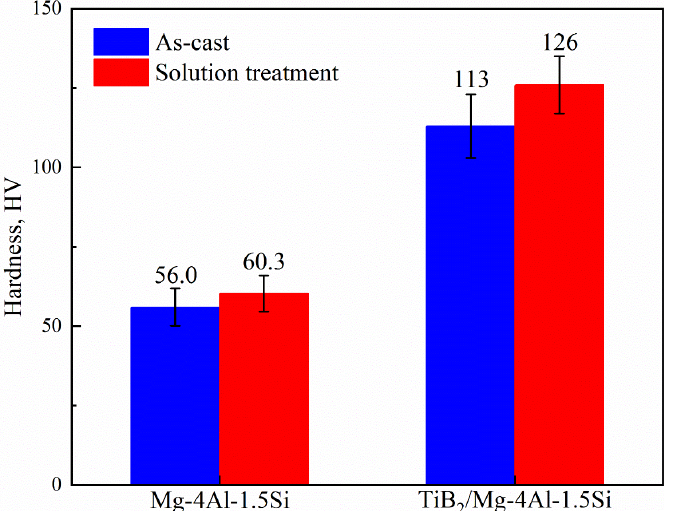
Figure 7. Vickers-hardness of the alloys and the composites in as-cast state and after solution treatment.